Question: Describe this figure in one sentence.
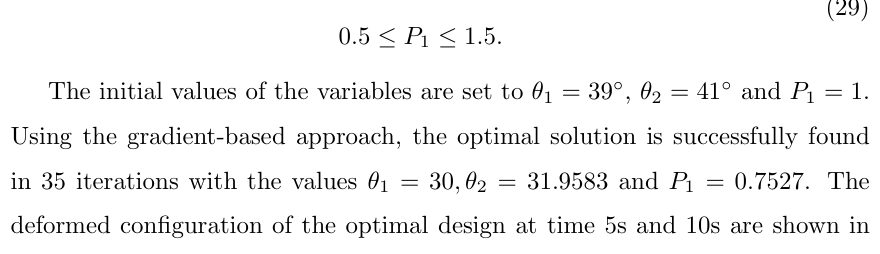
Answer: The optimization paths are plotted in Figure 6.